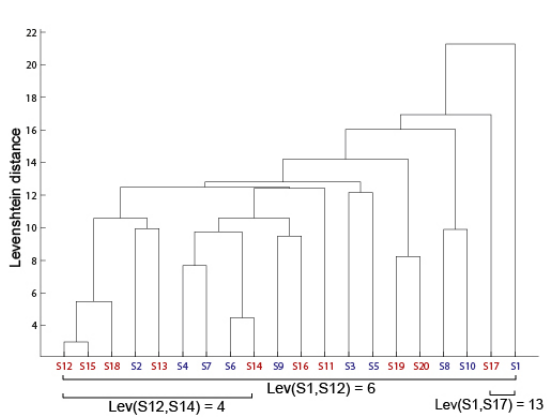
Figure 3. Tree-graph from eyePatterns redrawn to a